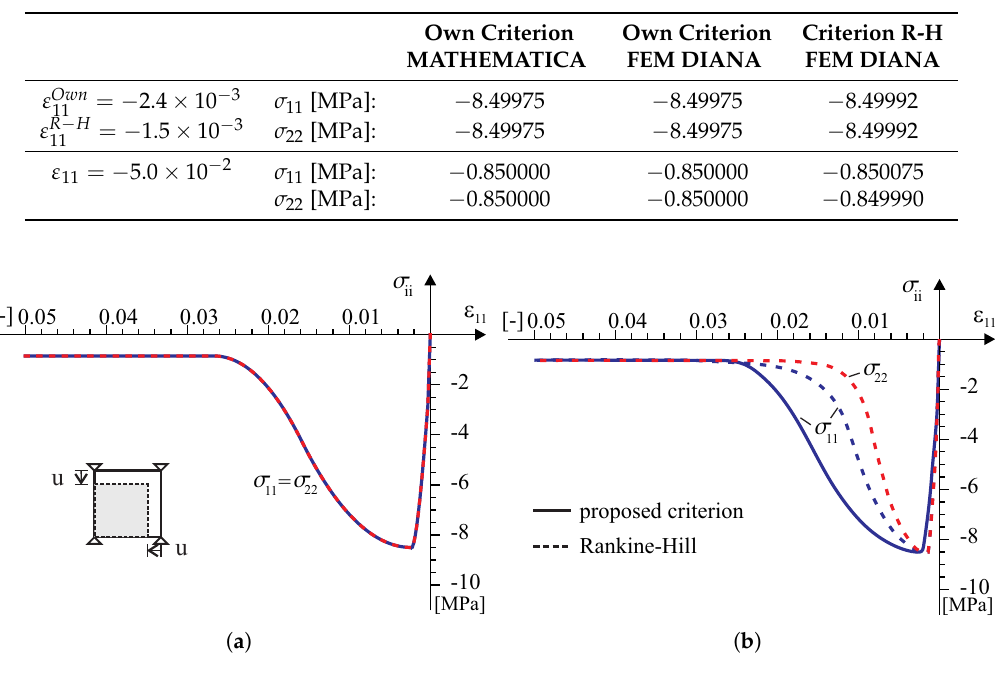
Figure 12. A strain field ε 11 < 0 and ε 22 < 0 single element test results: ( a ) symbolic computation by MATHEMATICA [40], ( b ) FEM analysis in TNO DIANA